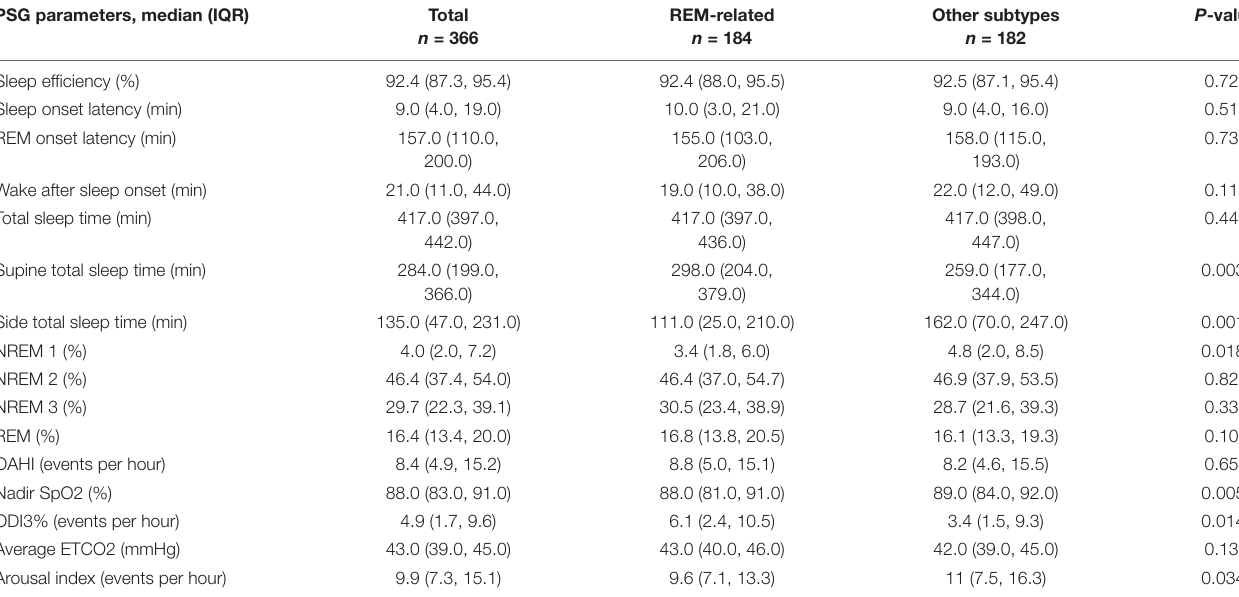
TABLE 4 | Comparison of polysomnographic parameters between REM-related OSA versus other subtypes. PSG parameters, median